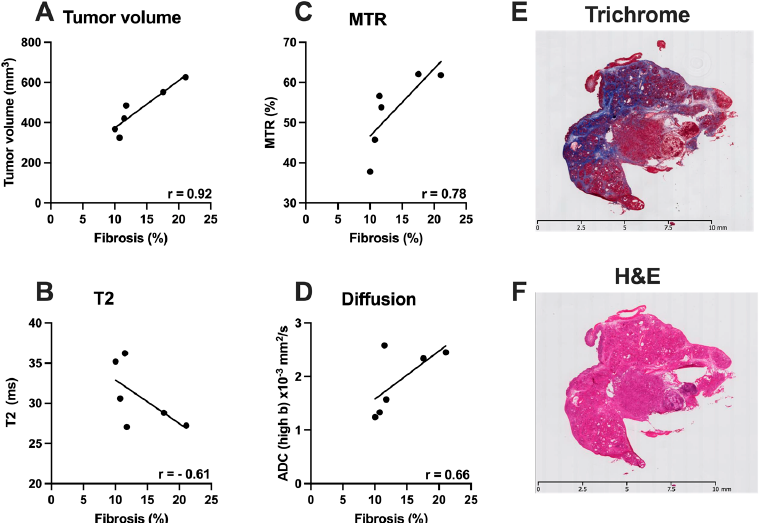
Figure 4. Relationship between MR and histological parameters in the advanced stages of PDAC. ( A ) showing relationship between Tumor volume (mm 3 ) and Fibrosis (%); ( B ) showing relationship between T2 (ms) and Fibrosis (%); ( C ) relationship between MTR (%) and Fibrosis (%); ( D ) ADC low b ( × 10 − 3 mm 2 /s) and Fibrosis (%); ( E , F ) Representative images of Masson’s Trichrome and H&E stained